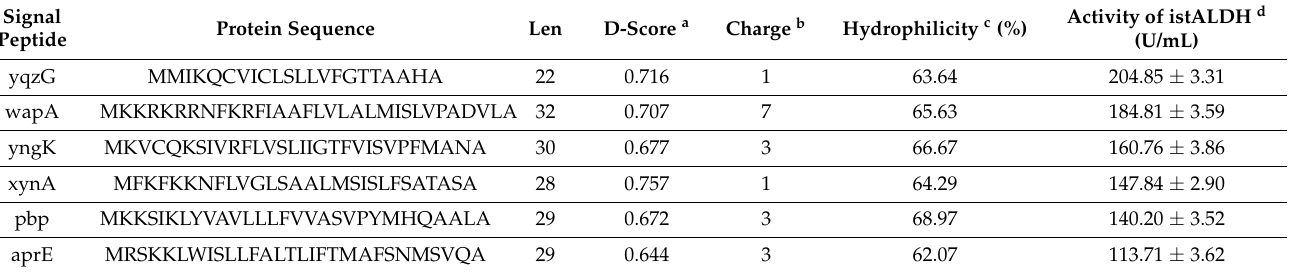
Table 3. Efficiency of different SPs in istALDH